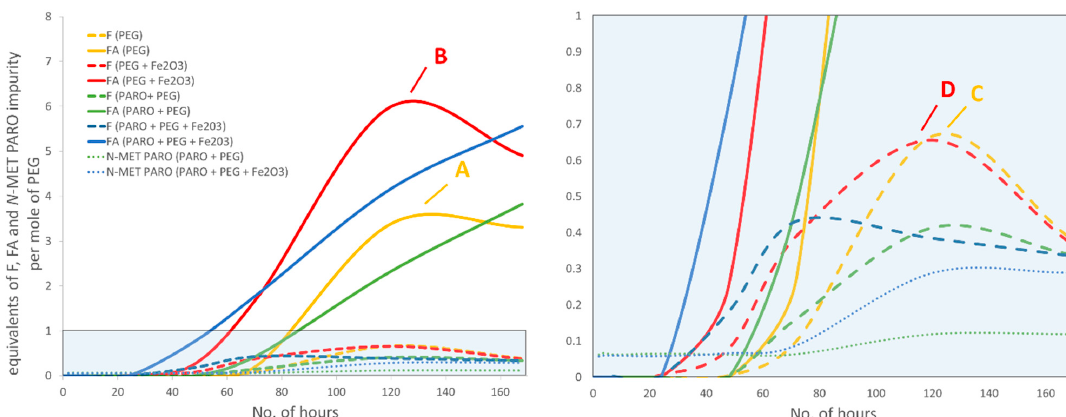
Figure 3. Polyethylene glycol (PEG) and paroxetine (PARO) degradation kinetic study. The monitored degradation products were as follows: Formaldehyde (F), depicted with dashed lines, formic acid (FA), depicted with solid lines, and N -methyl paroxetine ( N -MET PARO), depicted with dotted lines. Samples with PEG only (yellow lines), PEG with iron oxide (Fe 2 O 3 ) (red lines), PARO and PEG in separate glass inserts (green lines), and PARO and PEG with Fe 2 O 3 in separate glass inserts (blue lines) were subjected to stress testing at 60 °C for up to seven days in closed vials. Points C, D and A, B indicate the maximum formaldehyde and formic acid concentrations, respectively. The time in hours is presented on the x axis, the equivalents per mole of PEG are presented on the y axis. The left graph represents the whole y-axis range, while the right graph represents an enlarged y-axis section.